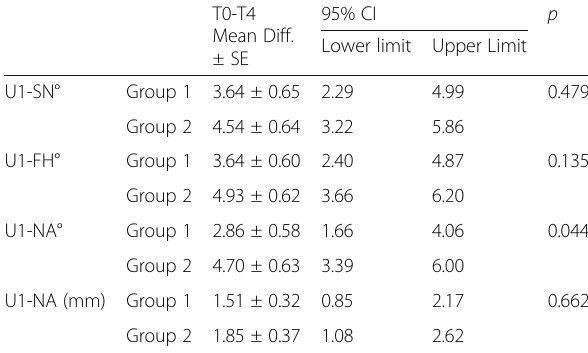
Table 4 Comparison of upper incisor inclination changes between the groups